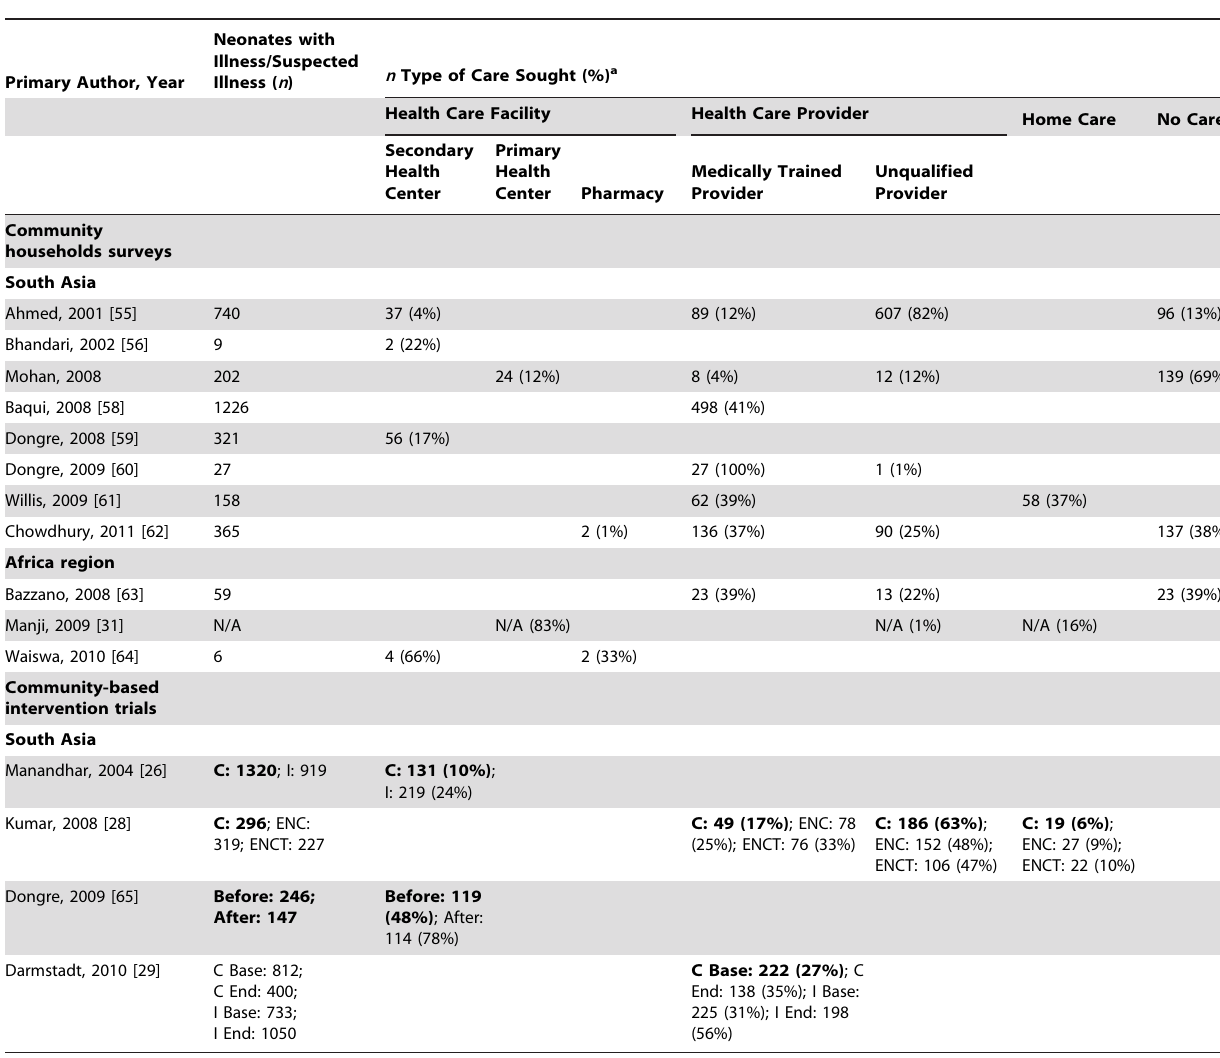
Table 4. Community-based studies that describe type of care sought for ill or suspected ill neonates.